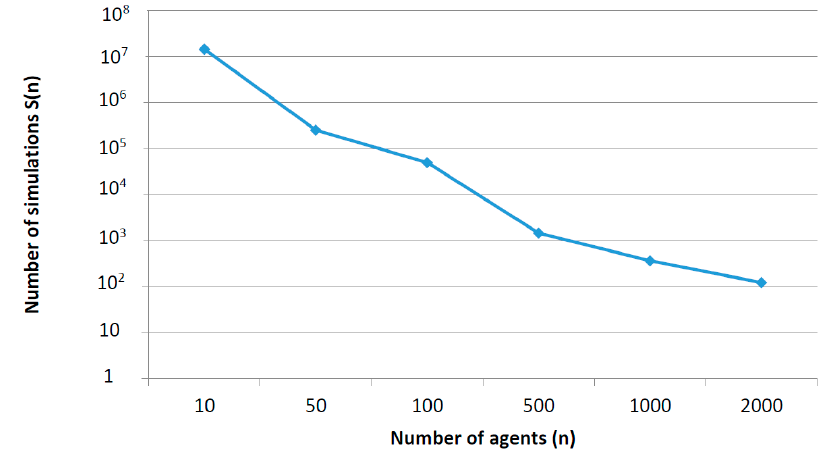
Figure 17. Function S(n) .